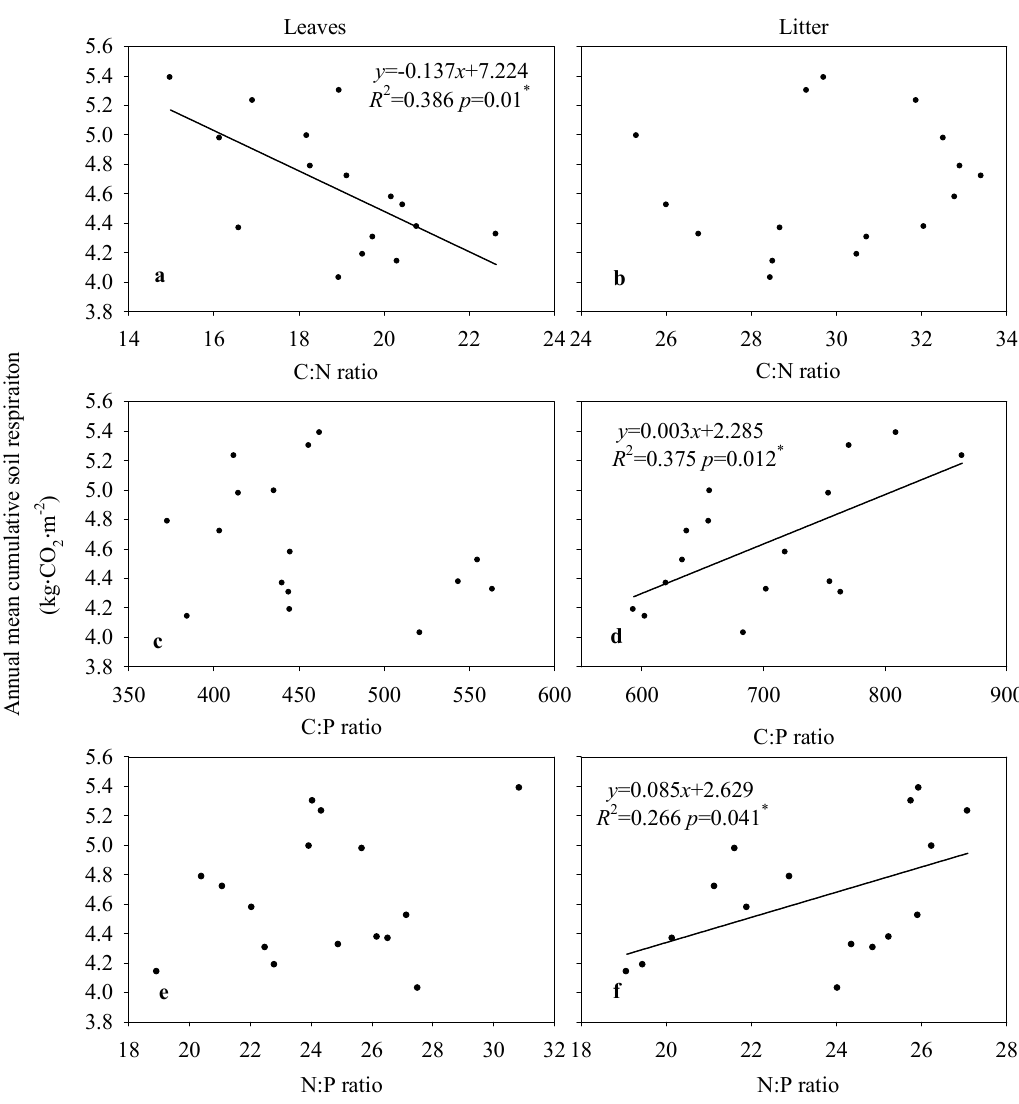
Figure 7. Relationships between the annual mean cumulative soil respiration rate and stoichiometry in leaves and litter on moso bamboo. The data means three plots in each stand and the total mean value of each stand ( n = 16). ( a , c , e ), is the relationships between annual mean cumulative respiration and leaves C:N ratio, C:P ratio and N:P ratio; ( b , d , f ), is the relationships between annual mean cumulative respiration and litter C:N ratio, C:P ratio and N:P.